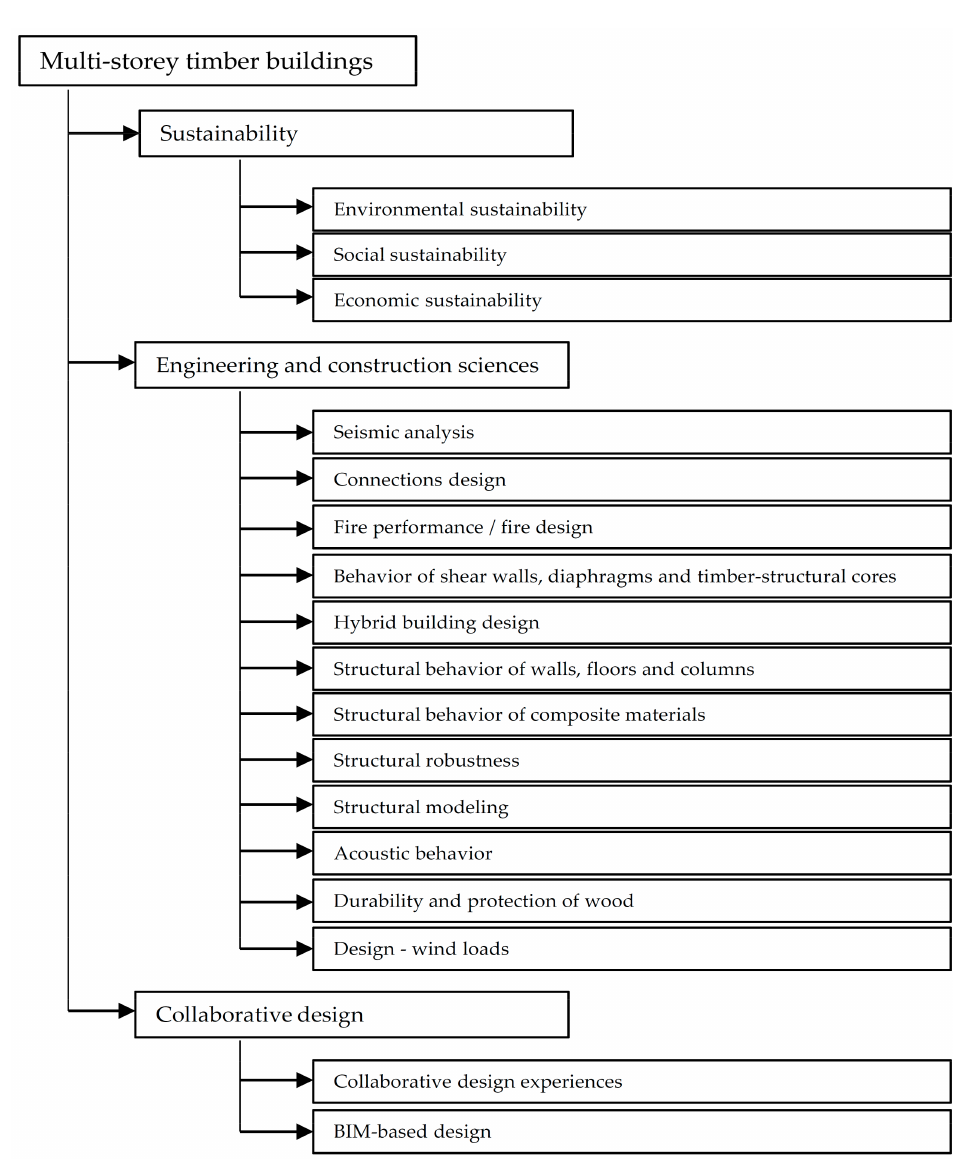
Figure 2. Categorization of data fields from scientific articles on multi-storey timber